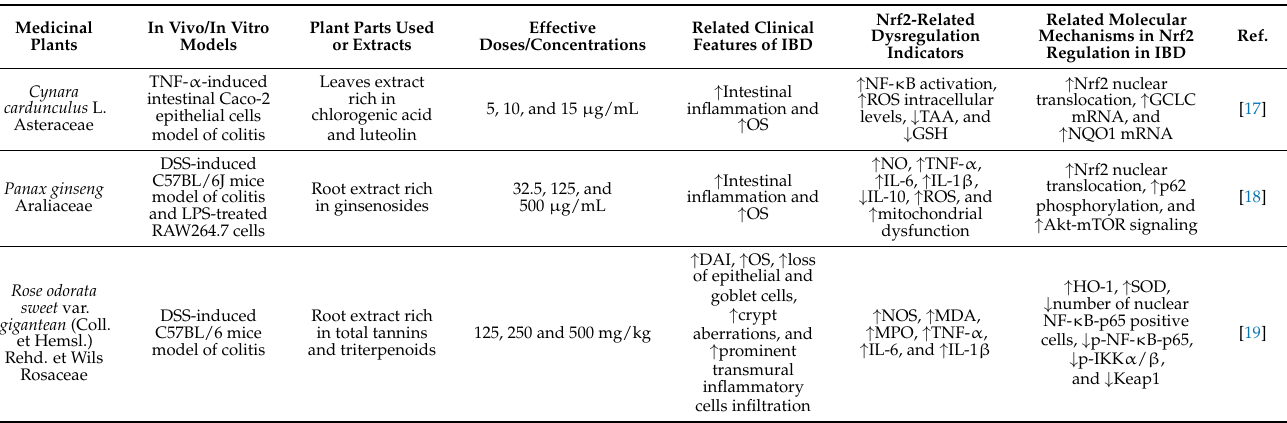
Table 1. Studies regarding the use of medicinal plants with regulatory effects on Nrf2 signaling pathway in